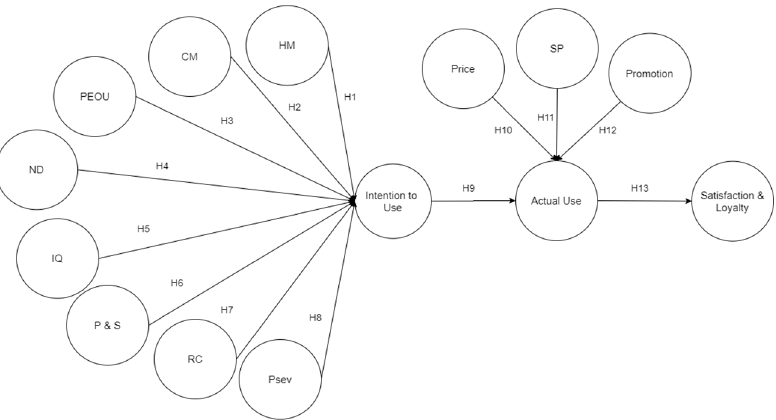
Figure 1. Theoretical Research Framework.